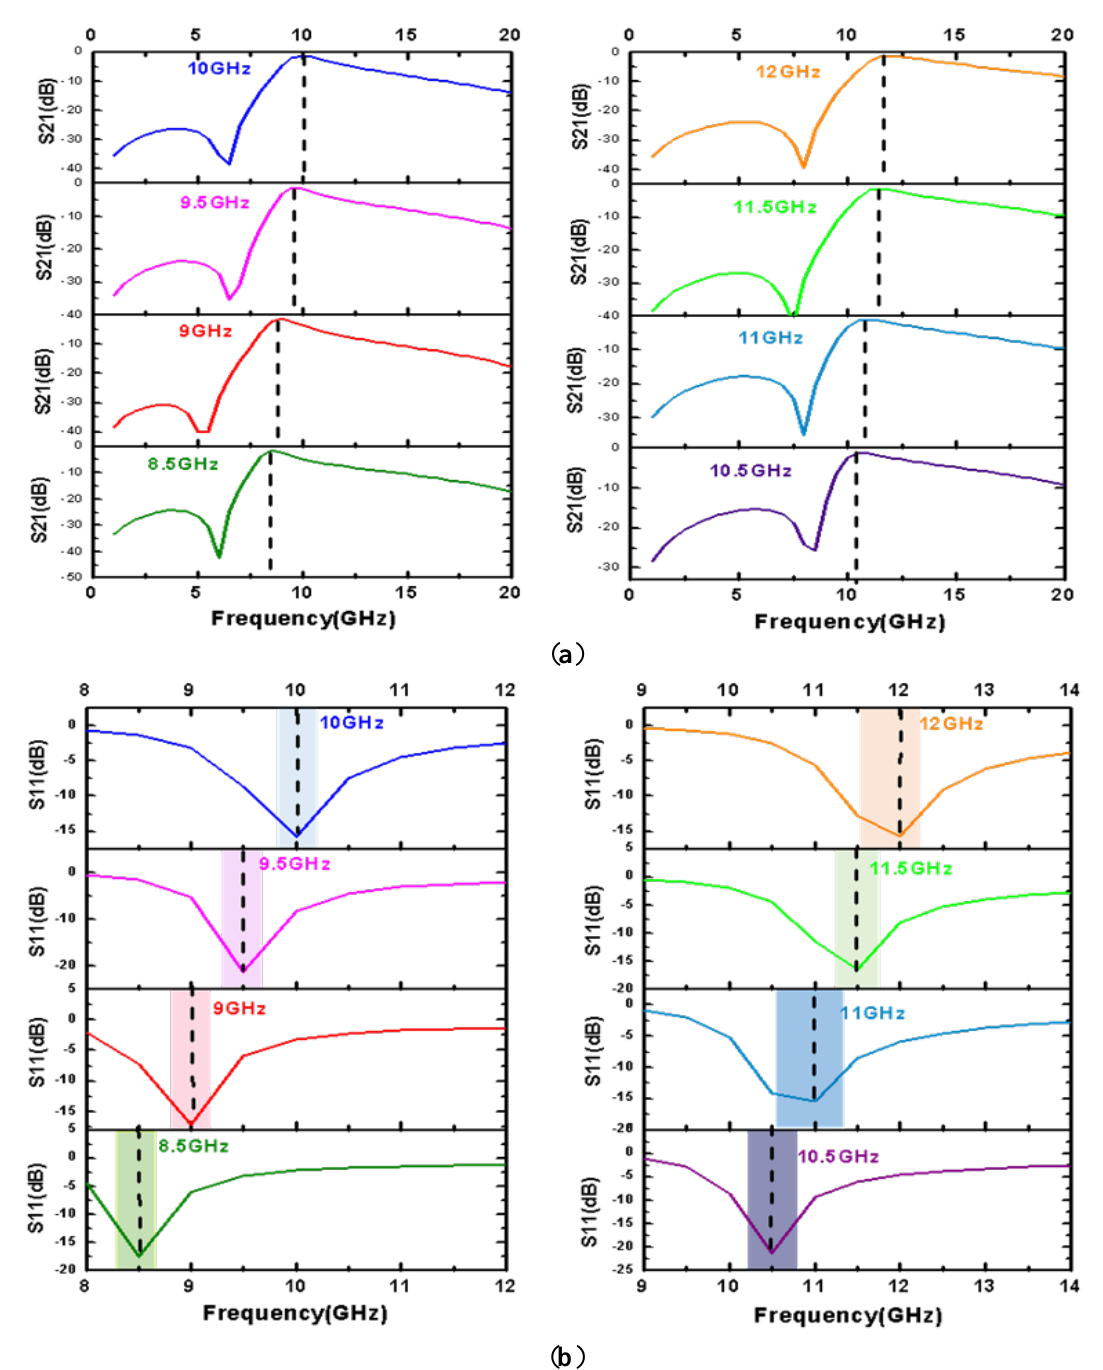
Figure 7. ( a ) S21 simulation results of the bandpass MEMS filter with different center frequency; ( b ) S11 simulation results of the bandpass MEMS filter for different widths of the top electrode.